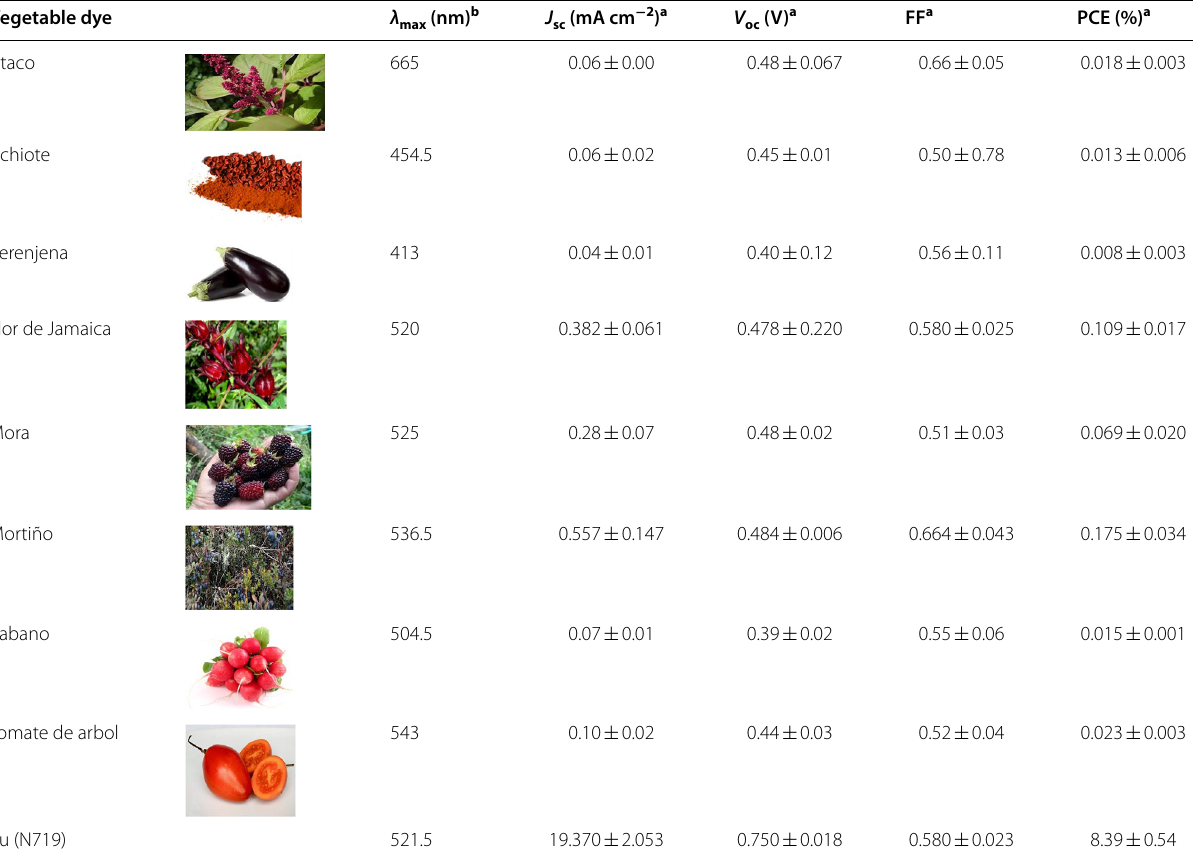
Table 1 Photoelectrochemical parameters of the DSSCs using extracts of vegetable dyes extracted with ethanol at pH 1, and Ru (N-719) dye as